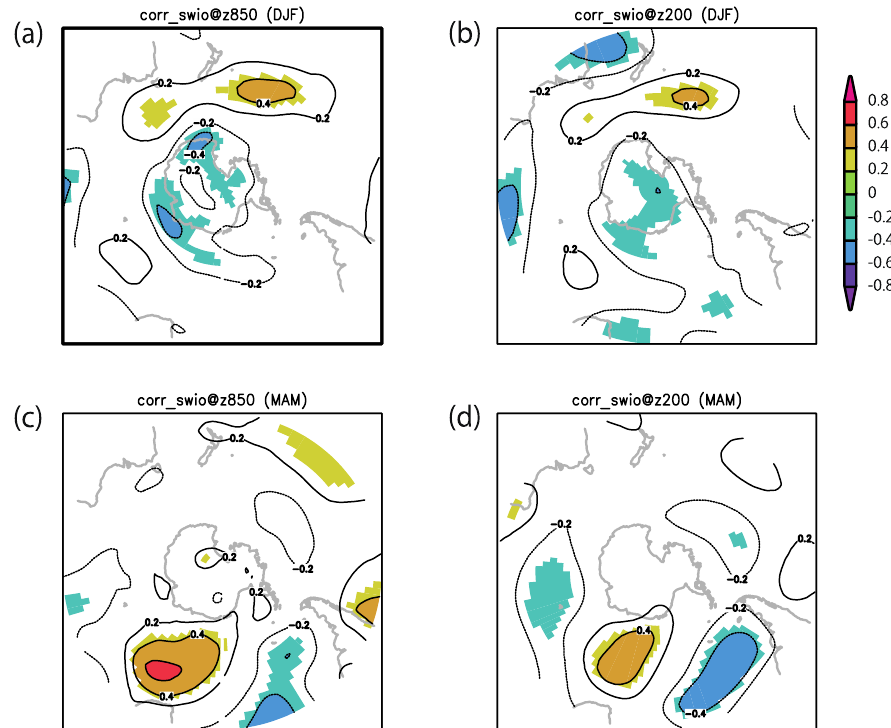
Figure 8. Simultaneous correlation map of z850 (left panels) and z200 (right panels) anomalies to observed TCF anomaly over the SWIO region (averaged over 10 – 30° S, 40 – 70° E). Significant areas above 90% are shaded. ( a ) DJF z850, ( b ) DJF z200, ( c ) MAM z850, ( d ) MAM z200.